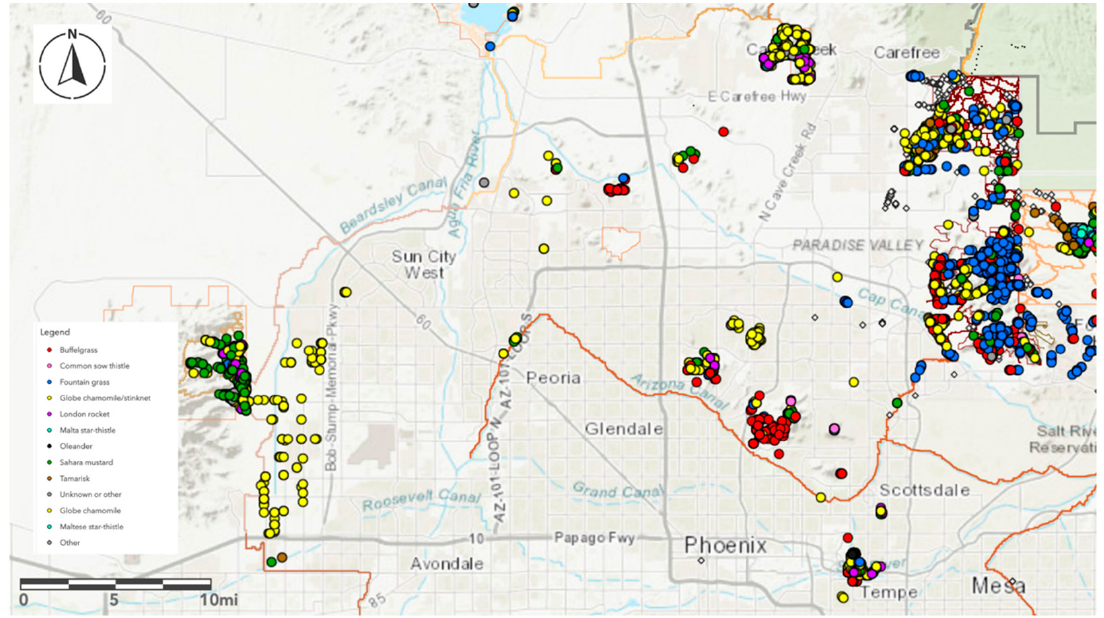
Figure 3. Example map for Desert Defenders; colored points represent different species of focal invasive plants identified across the region as of Spring 2021. Table 2. Focal invasive plant species and number of data points for each produced by community scientists from